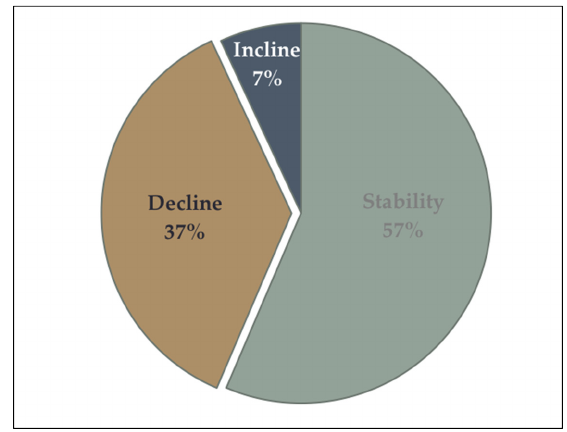
Figure 1. This figure represents the sum of longitudinal trends in religiosity as adolescents entered emerging adulthood, showing net decline. Author calculation based on findings reported in [12].